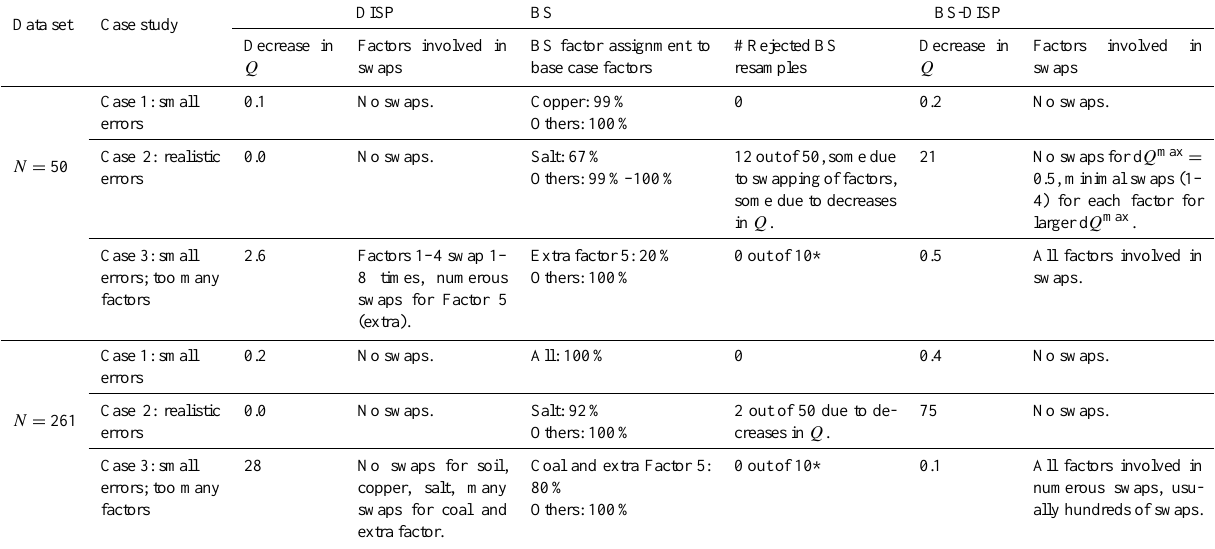
Table 1. Summary of error estimation diagnostics by data set and case